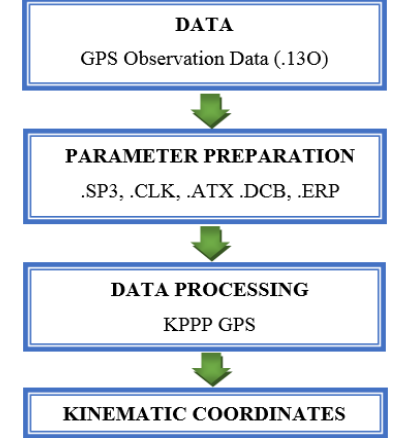
Figure 2. Main work flow of GPS data processing using